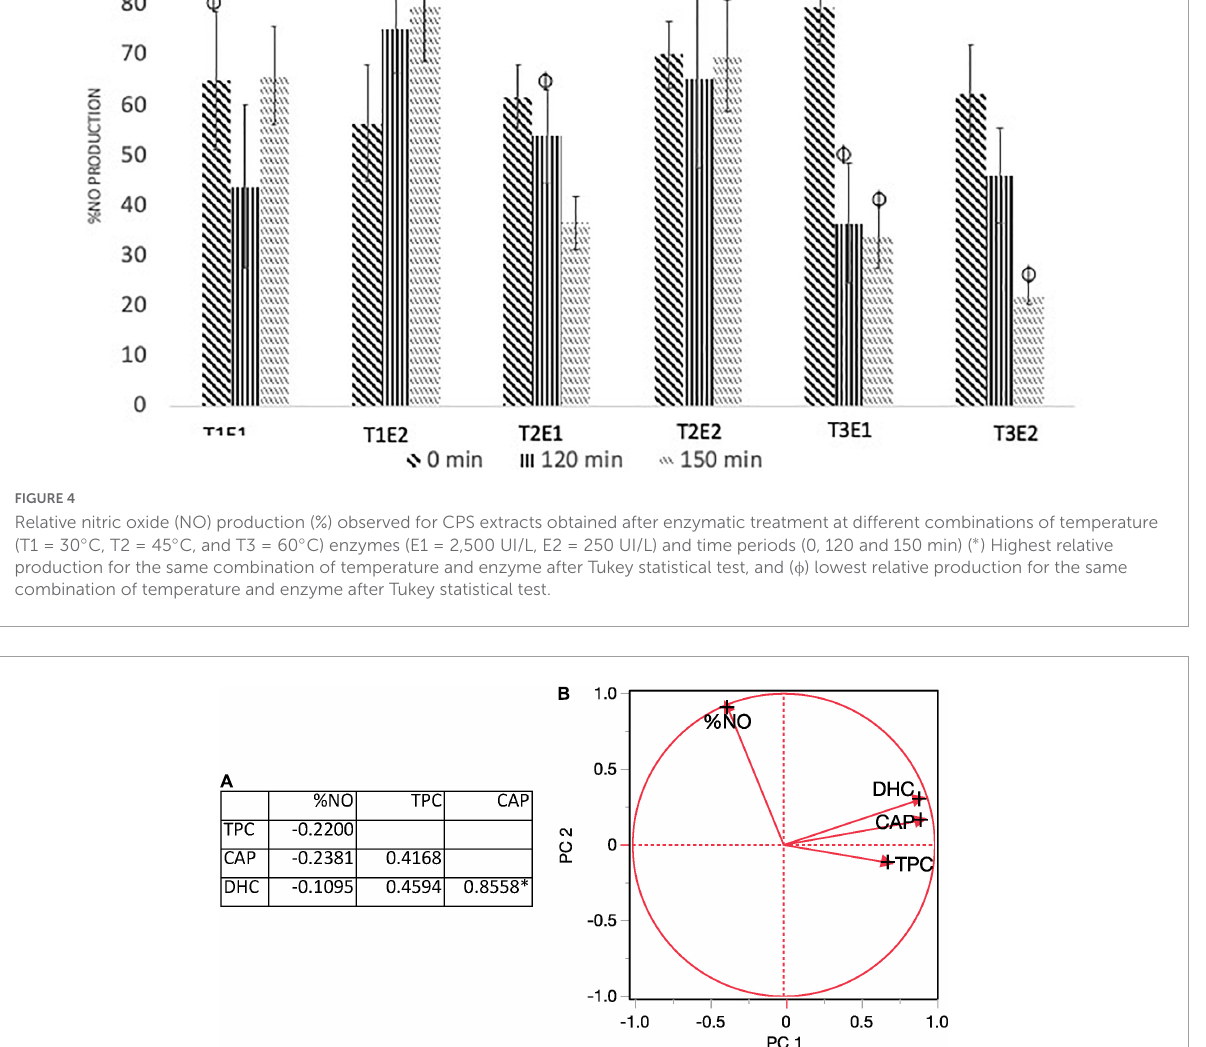
extraction due the oxidation of phenolic compounds